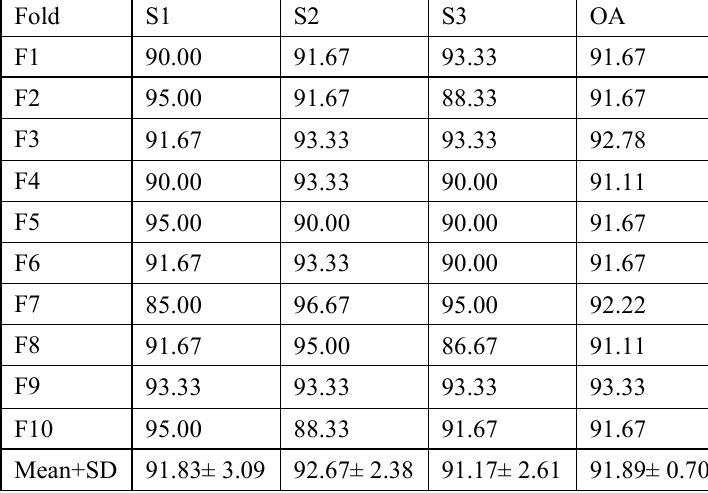
Table 4. Performance analysis of